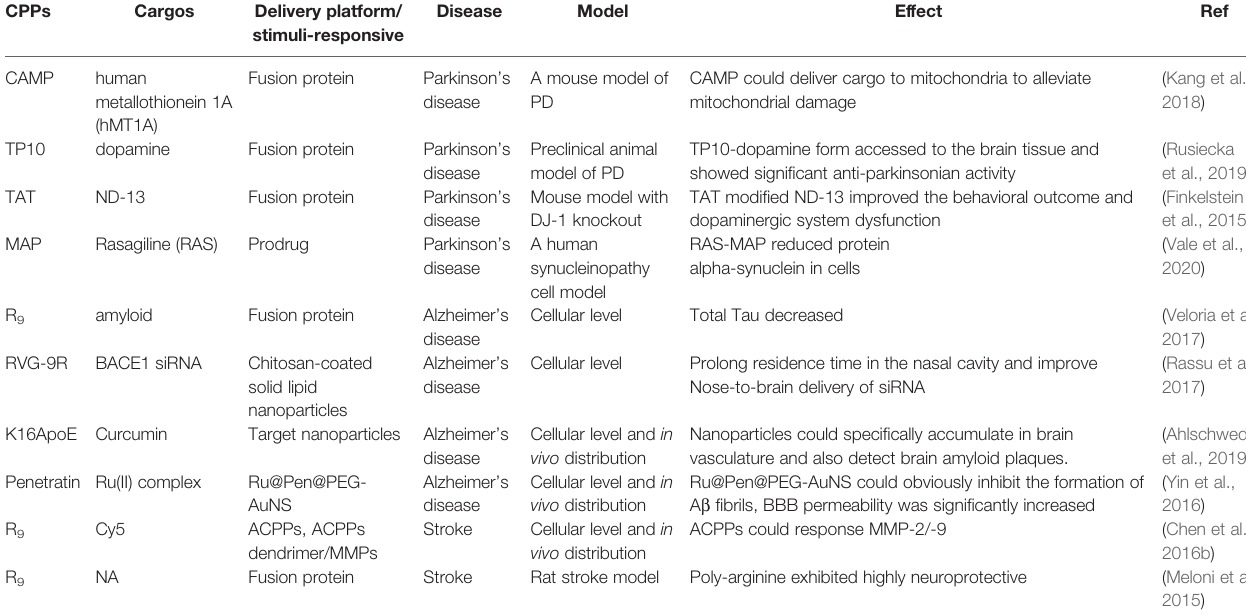
TABLE 3 | Recently developed on CPPs application in central nervous system